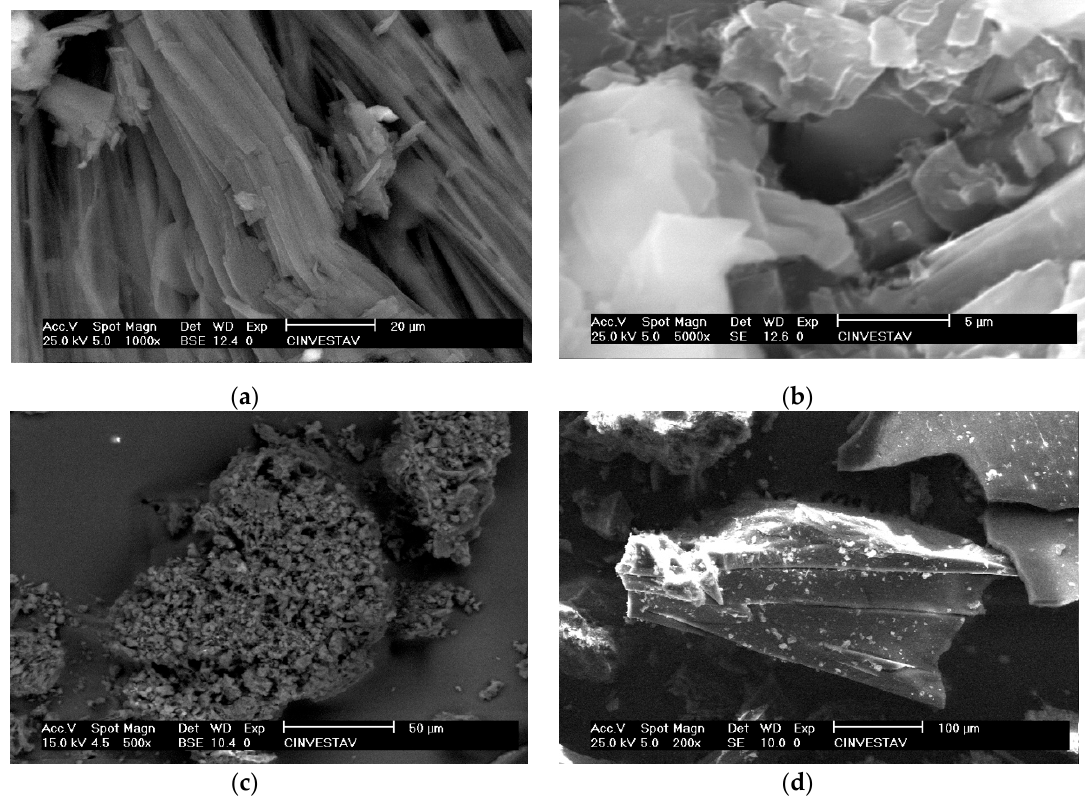
Figure 10. SEM images of the self-assembly structures of strand and membrane-shaped bisteroid derivatives: ( a ) 5 in EtOAc; ( b ) 5 in hexane / EtOAc (25:1) showing membrane-shaped structures; ( c ) 8c in EtOAc (strands-shaped structures); ( d ) 8c in hexane / EtOAc (25:1) (membrane-shaped structures).